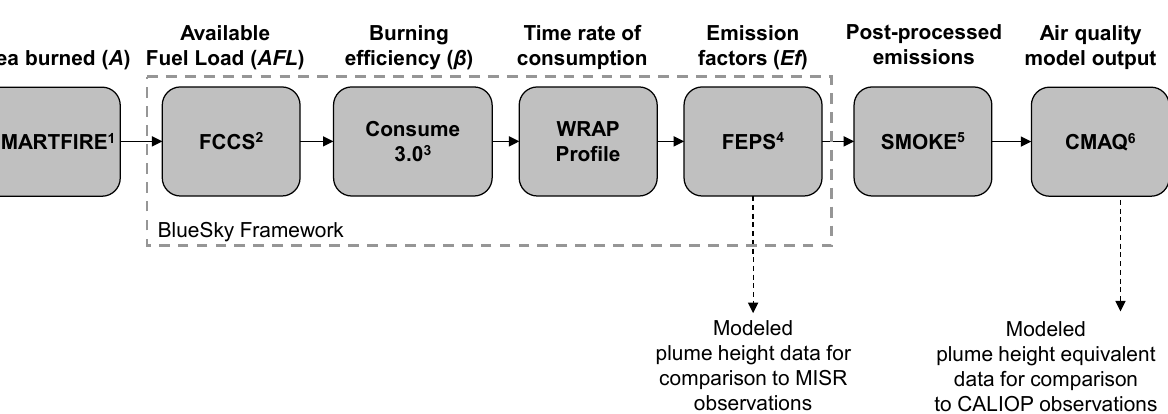
Figure 2. Model pathway used to develop estimates of plume height and smoke predictions for comparison to MISR and CALIOP observations. FCCS, Consume3.0, and FEPS are used as implemented in the BlueSky Framework, version 3.0.0 [36]. 1 Sullivan, et